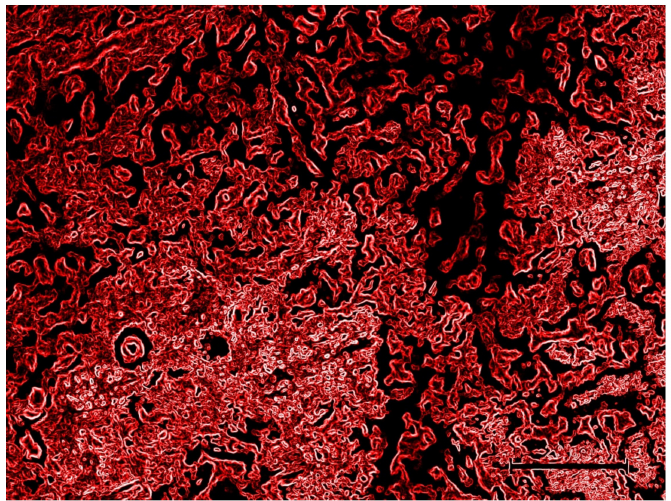
Figure 2. Optical micrograph of base Al-Mg-0.6Si-0.35Fe alloy matrix.